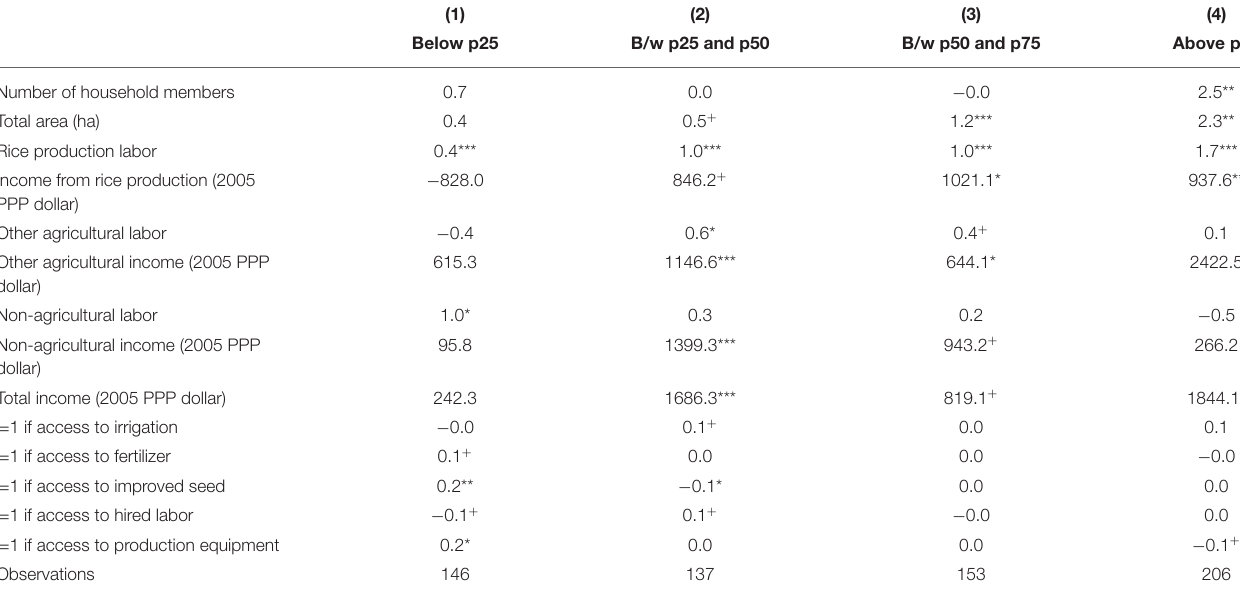
TABLE 7 | t -test of variables conditional on labor inputs of rice production in Burkina Faso, Côte d’Ivoire, Madagascar, and Sierra